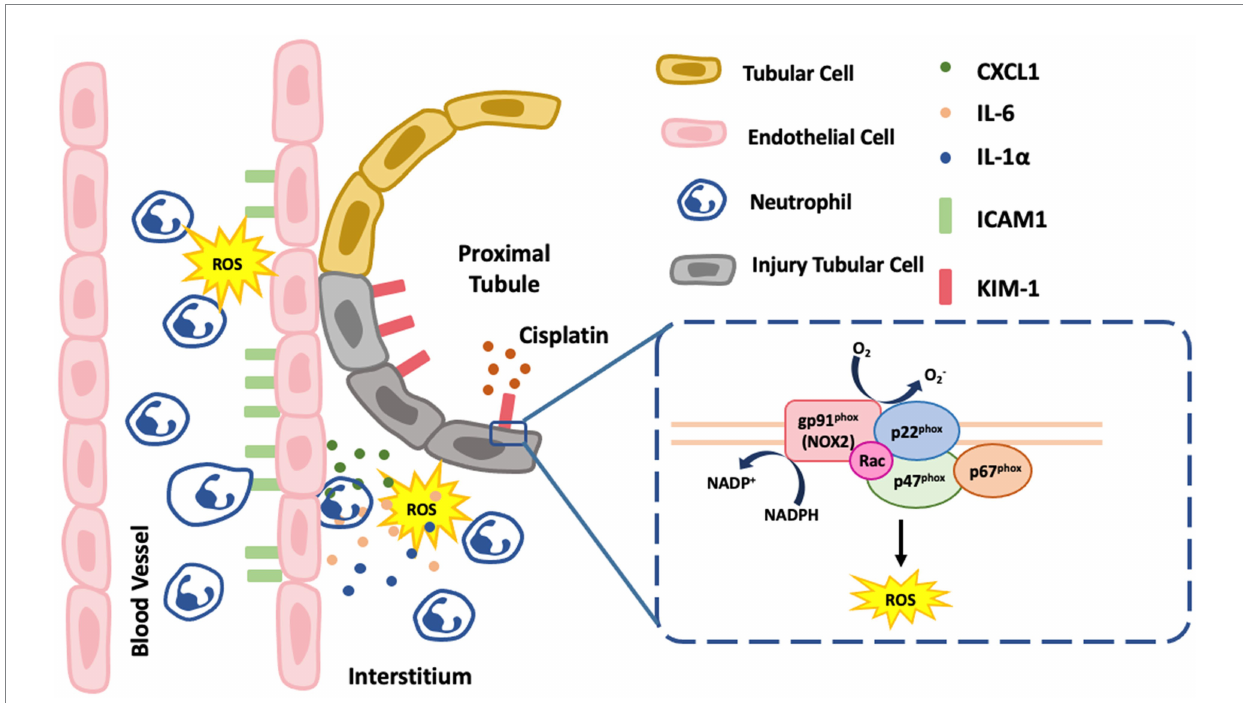
FIGURE 8 Schematic summarizing the mechanism of NOX2-induced ROS in the renal proximal tubular cells. NOX2 contributes to cisplatin-induced AKI and involves an increase Kim-1 and proinflammatory cytokines, IL6 and IL-1 α which also increase neutrophil infiltration with higher endothelial adhesion molecule ICAM-1 and chemokine CXCL1. The box in the figure is NOX2 which has multiple membrane-bound subunits of NADPH oxidase including gp91 phox , p22 phox , p67 phox , p47 phox , and